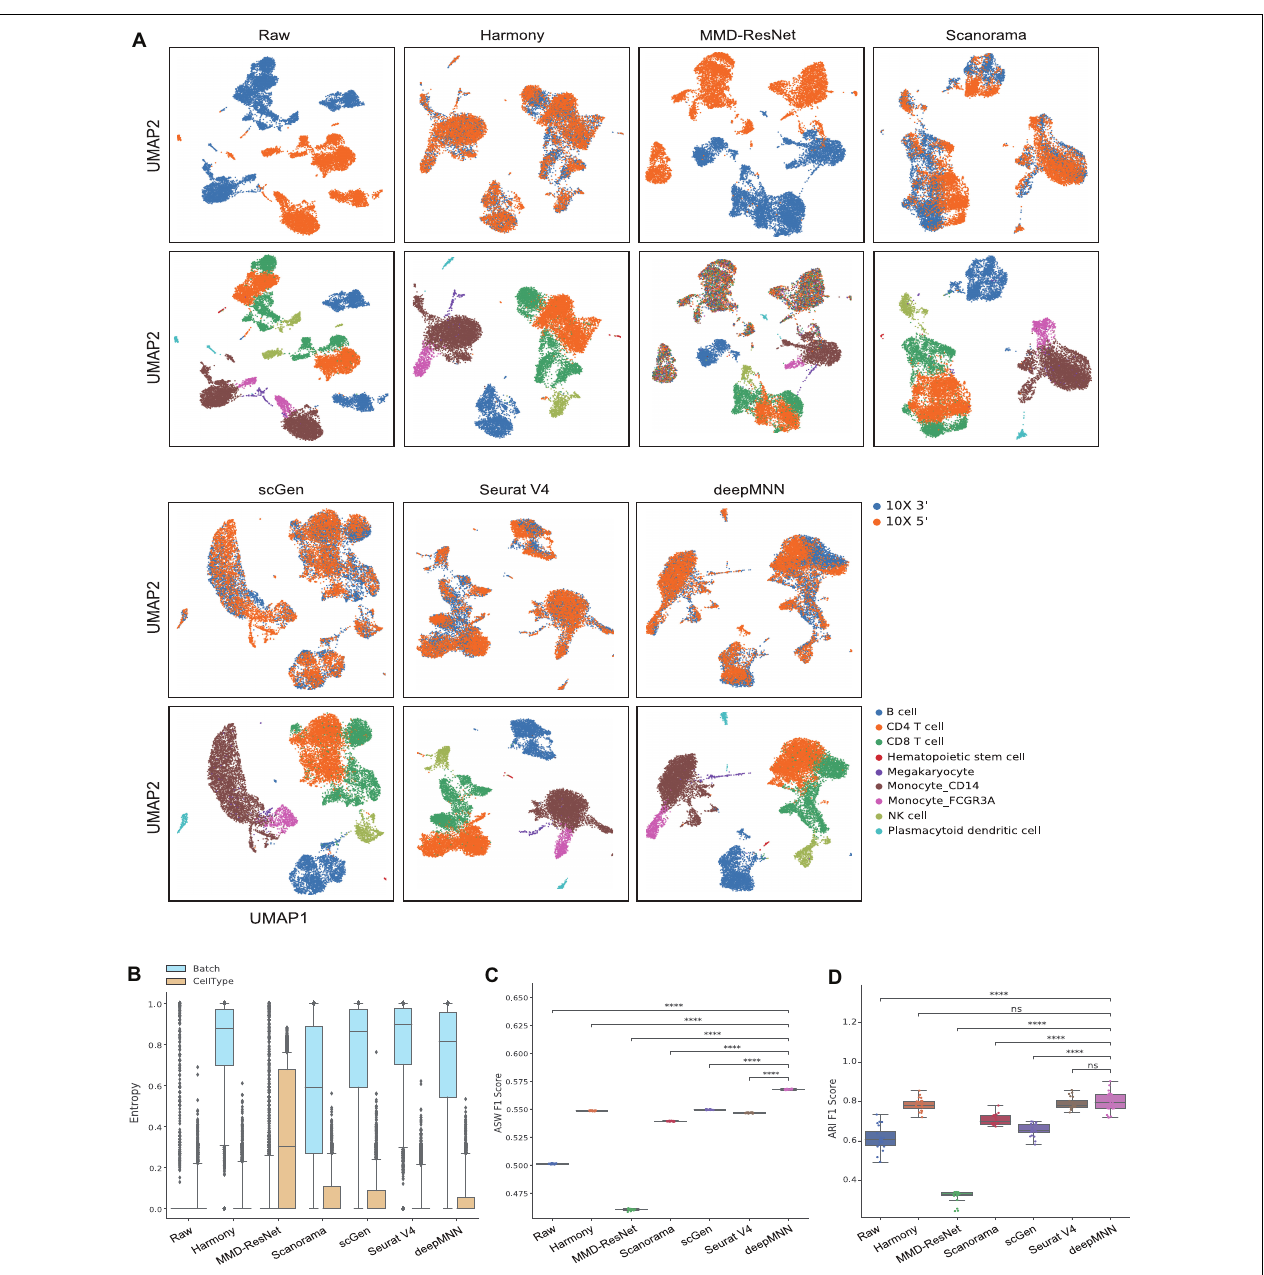
FIGURE 3 | Comparison of batch effect correction methods for the human peripheral blood mononuclear cell dataset of identical cell types with two batches. (A) Qualitative evaluation of the raw data, Harmony, MMD-ResNet, Scanorama, scGen, Seurat V4, and deepMNN using UMAP. The cells were colored by batches on the top row and colored by cell type on the bottom row. (B) The batch and cell type entropies resulting from the batch correction methods. The plots show the median (line within box), 25th and 75th percentiles (box), 5th and 95th percentiles (whiskers), and outliers (diamond points). (C) The ASW F1 score resulting from different batch correction methods. (D) The ARI F1 scores resulting from different batch correction methods. ∗∗∗∗ p ≤